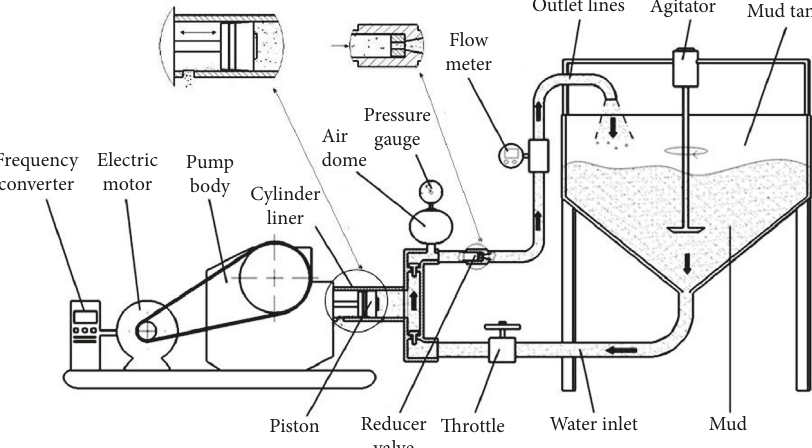
Figure 1: Principle of test rig.